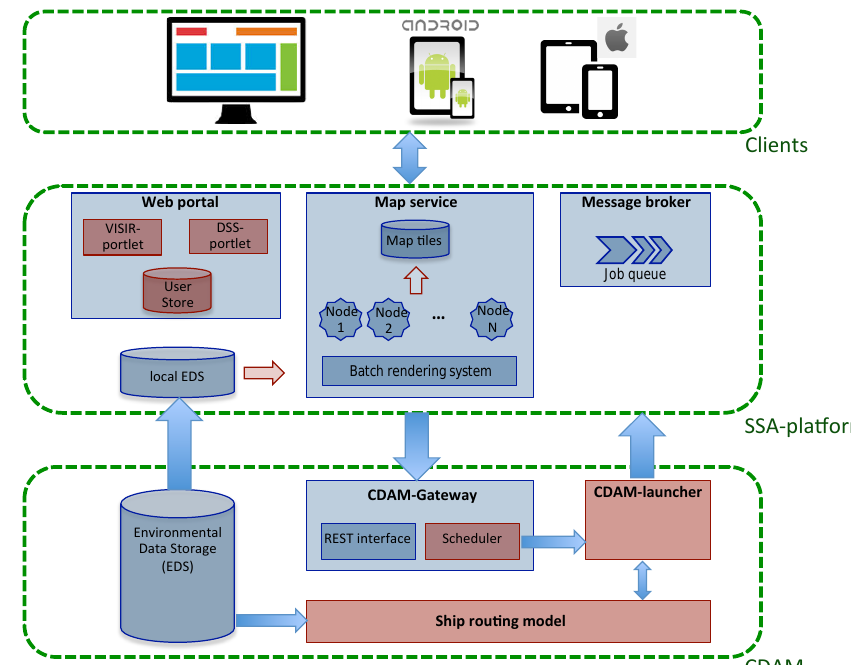
Figure 2. Functional structure of the TESSA system. Red boxes refer to VISIR-specific components hosted on the TESSA infrastructure (blue). Cylinders represent databases; boxes are services; icosagons are computational